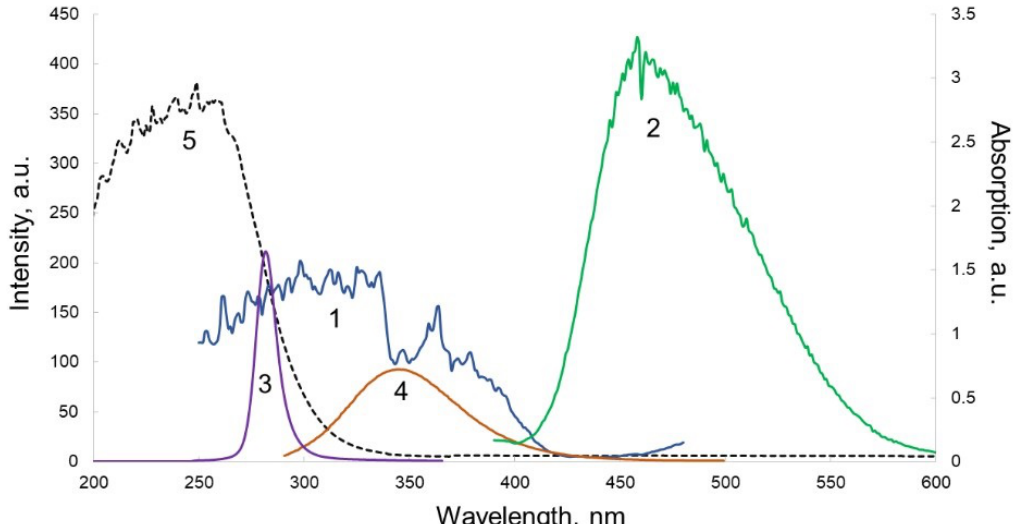
Figure 5. Excitation ( 1 ) and emission ( 2 ) spectra of the ZnS:Cu luminophore, UV-LED radiation spectrum ( 3 ) and fluorescence spectrum of BSA ( 4 ); ( 5 ) shows the range of spectrum absorbed by glass